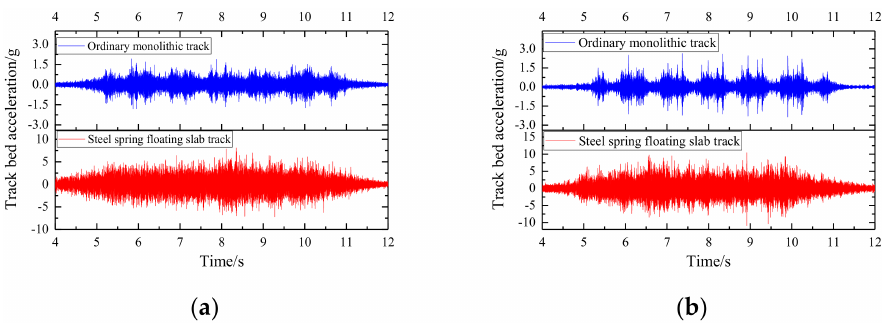
Figure 10. Comparison of vertical acceleration of track bed. ( a ) Straight line segment; ( b ) curved segment.